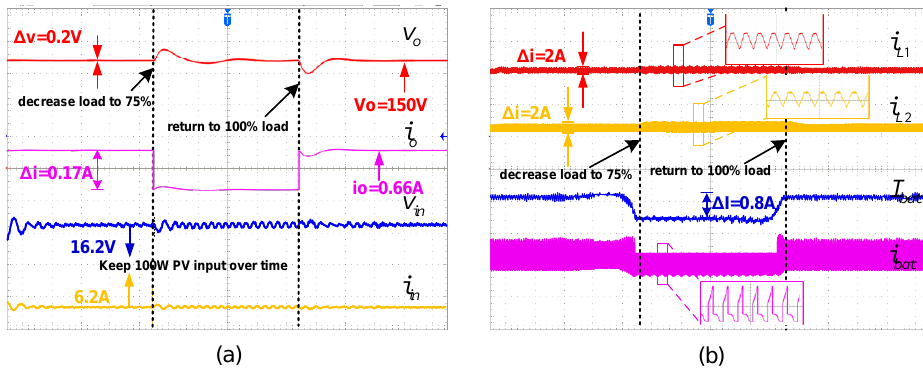
Figure 11. Dynamic waveforms of ( a ) v in , i in , v o , and i o , and ( b ) i L 1 , i L 2 , I bat , and i bat during load transience.